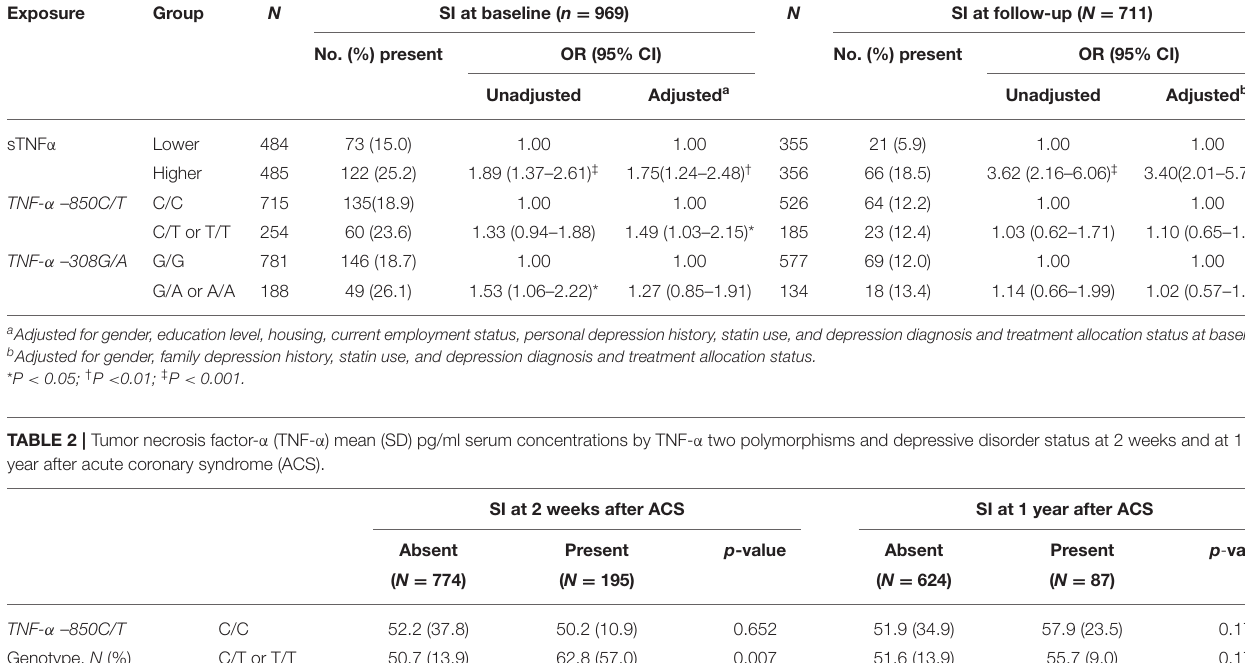
TABLE 1 | Individual associations of serum tumor necrosis factor-alpha (sTNF α ) level and two TNF- α polymorphisms with SI. Exposure